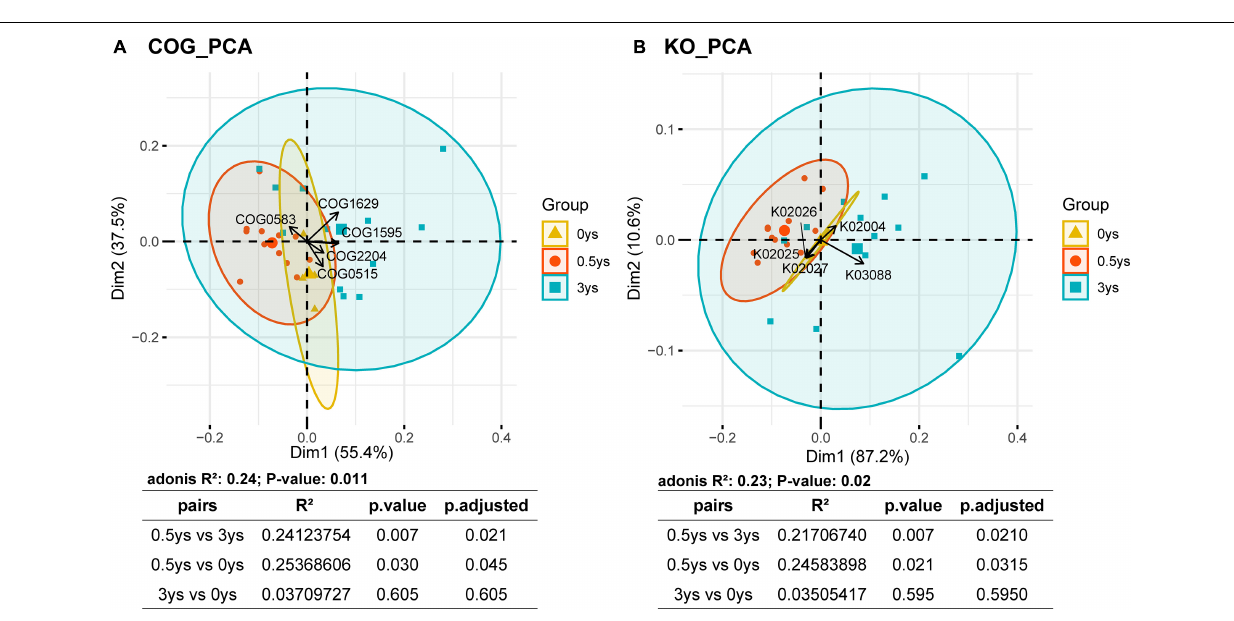
Frontiers in Microbiology |